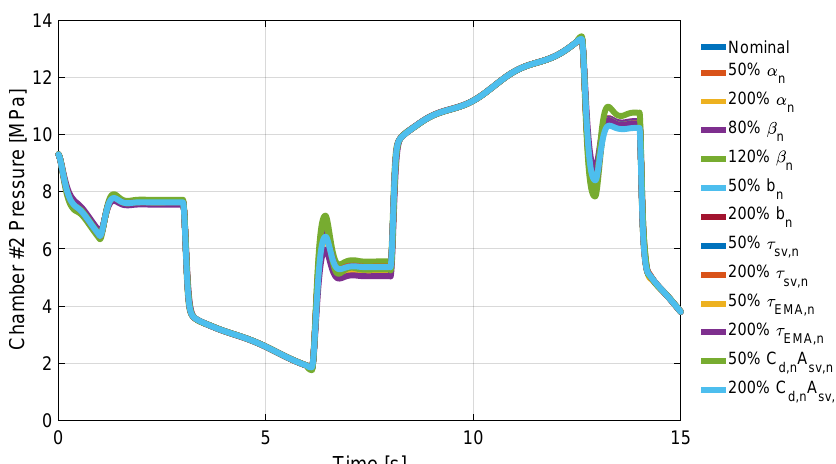
Figure 10. Simulation #1: Chamber #2